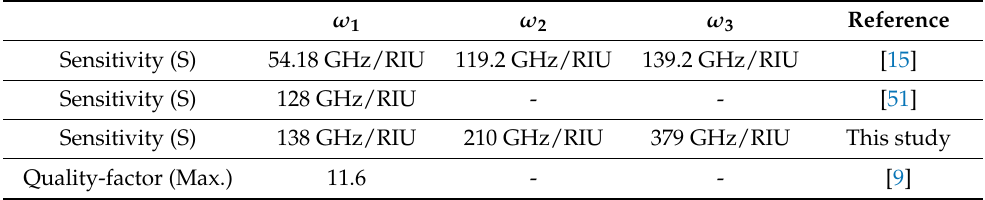
Table 2. The comparison of sensing performances in this study and literature